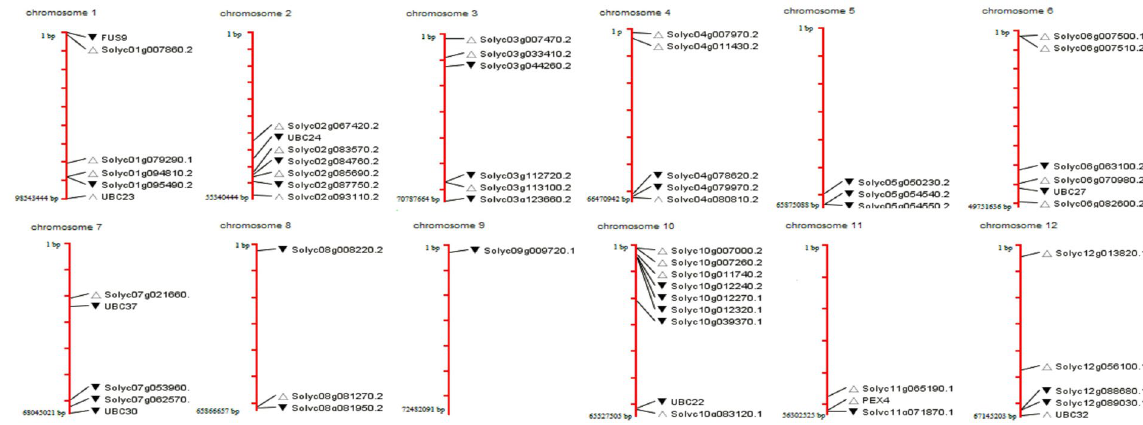
Figure 1. The diagram represents chromosomal map of tomato genome constructed by ArkMap software. All 59 E2 enzymes of tomato are localized on 12